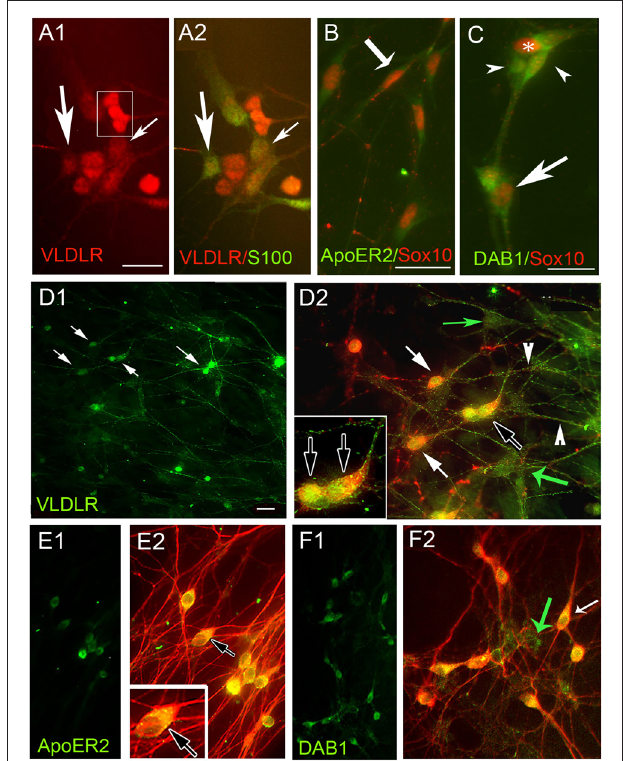
FIGURE 2 | Olfactory ensheathing cells (OECs) and GnRH neurons express Reelin receptors apolipoprotein E receptor 2 (ApoER2), very low-density lipoprotein receptor (VLDLR) and the adaptor protein Disabled 1 (Dab1) in explants. (A–F) Periphery of explants double-labeled for OECs (A–C) and GnRH cells (D–F) with indicated antibodies. (A) VLDLR (red) is expressed by OECs (green, S100, arrows). In addition, VLDLR highlighted positive cells associated with OECs (boxed area A1 ) that did not stain for OEC markers. OECs ( B,C Sox10, red) co-expressed ApoER2 ( B , green, example shown by arrow) and Dab1 ( C , green, example shown by arrow). Sox10 negative Dab1 positive cells (arrowheads) were associated with OECs. GnRH cells ( D–F , red, white arrows), co-expressed VLDLR ( D , green) ApoER2 ( E , green) and Dab1 ( F , green). Numerous non-GnRH positive VLDLR cells ( D2 , green arrows) and Dab1 cells ( F2 , green arrow) were detected, consistent with OEC expression described above. TUJ1 was used to stain both GnRH cells and olfactory axons in (E,F) . Although GnRH cells co-expressed ApoER2, olfactory fibers were devoid of staining (no fibers detected in E1 and fibers only red in E2 ). Dab1 was absent from the majority of olfactory fibers as well (F) . Scale Bar = 100 µ m in (A–C) . Scale Bar = 50 µ m in (D1,E1,F1) ; 100 µ m in (D2,E2,F2) , double labeled images of (D1,E1,F1) , respectively. Insets in (D2,E2) correspond to black arrow in lower